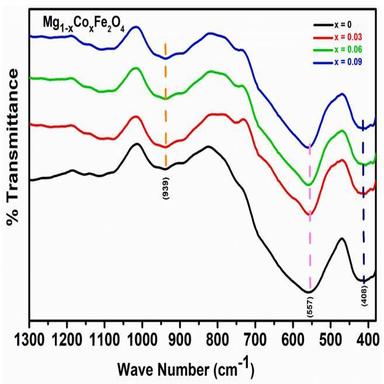
FTIR spectra of Mg1-xCoxFe2O4 with (x = 0, 0.03, 0.06, and 0.09) nanoparticles.